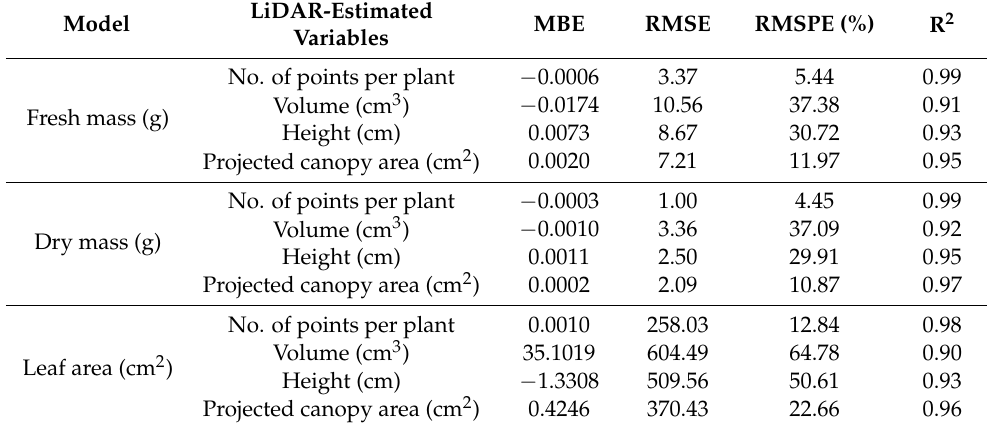
Table 3. Performance of derived model from dry mass, fresh mass, and leaf area of strawberry plants of four size classes ( n = 15) with their LiDAR-estimated plant variables in terms of mean bias error (MBE), root mean square error (RMSE), root mean square percent error (RMSPE), and coefficient of determination (R 2